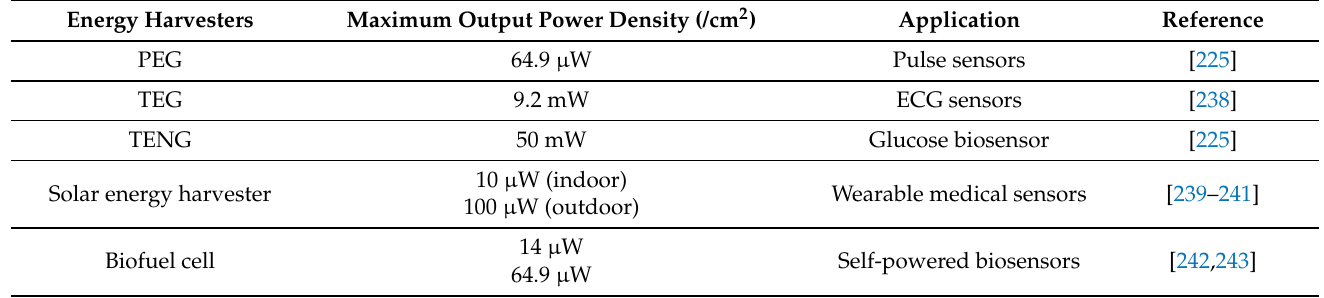
Table 10. Comparison of energy harvesters based on their power densities and application.